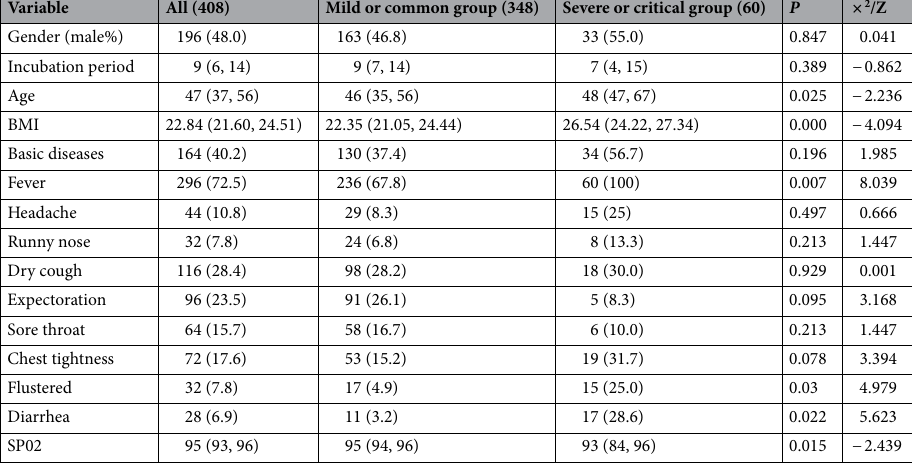
Table 1. Basic characteristics of COVID-19 in mild or common group and severe or critical group in training